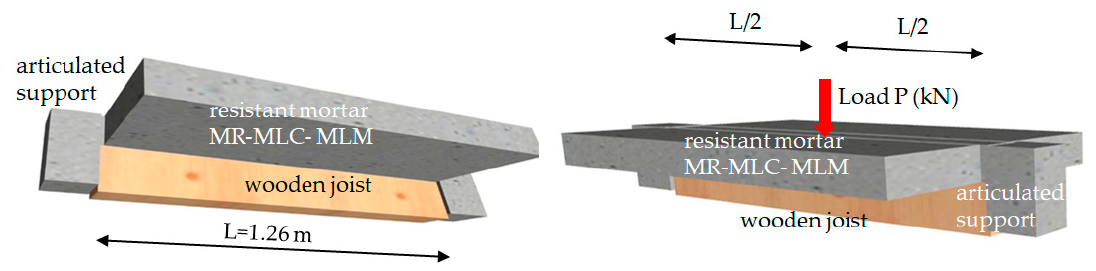
Figure 13. Discretization of the test model.